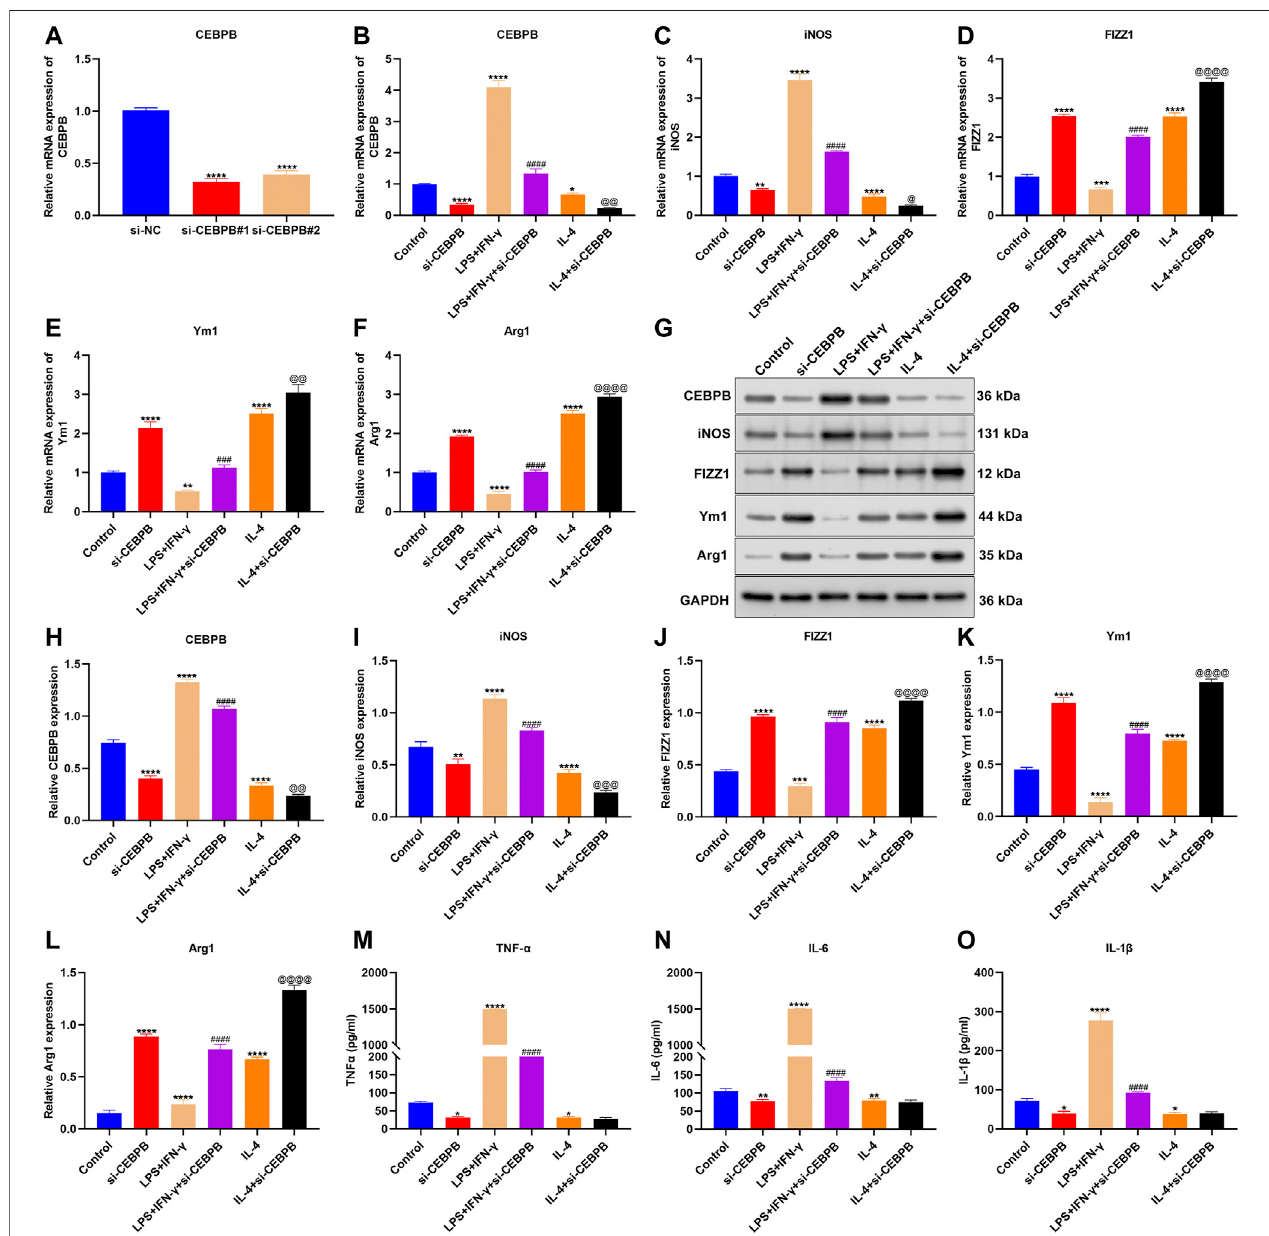
FIGURE 8 | CEBPB knockdown triggers anti-in fl ammatory M2-like polarization of macrophages. (A) RT-qPCR for verifying the expression of CEBPB in macrophages transfected with siRNAs targeting CEBPB. (B – F) RT-qPCR for quantifying the expression of CEBPB, M1-type marker (iNOS), and M2-type markers (including FIZZ1, Ym1, and Arg1) in macrophages treated with IFN- γ , and LPS, IL-4, or CEBPB knockdown. (G – L) Western blotting for evaluating the expression of CEBPB, M1-type marker (iNOS), and M2-type markers (including FIZZ1, Ym1, and Arg1) in macrophages treated with IFN- γ , and LPS, IL-4, or CEBPB knockdown. (M – O) ELISAdetecting the levels ofTNF- α , IL-6, and IL-1 β inthe supernatant ofmacrophages. Compared withcontrol, * p < 0.05; ** p < 0.01; *** p < 0.001; **** p < 0.0001. Compared with IFN- γ and LPS, ### p < 0.001; #### p < 0.0001. Compared with IL-4, @ p < 0.05; @@ p < 0.01; @@@ p < 0.001; @@@@ p <